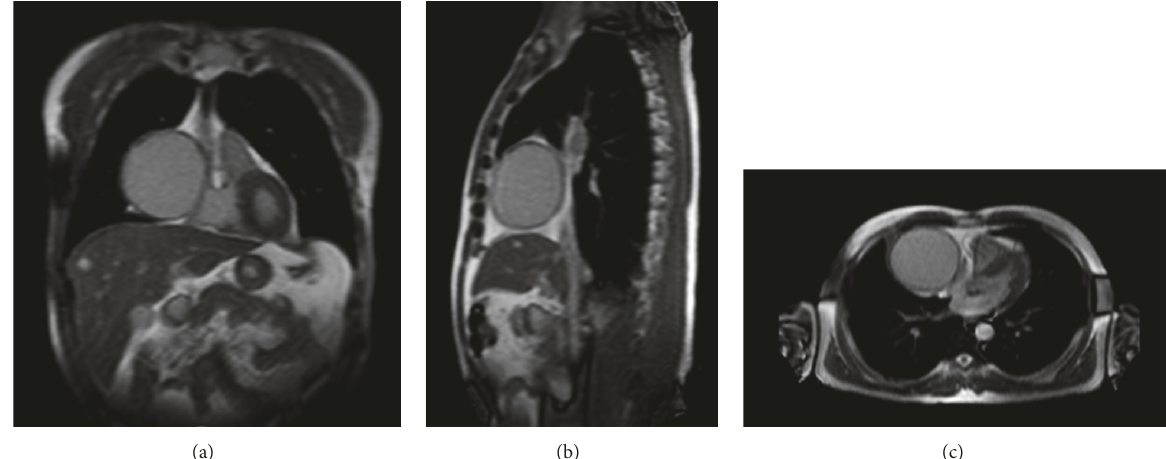
Figure 2: Coronal (a), sagittal (b), and transverse (c) views of thoracic MRI show a 9 cm pericardial cyst located at the right cardiophrenic angle compressing the right atrium.